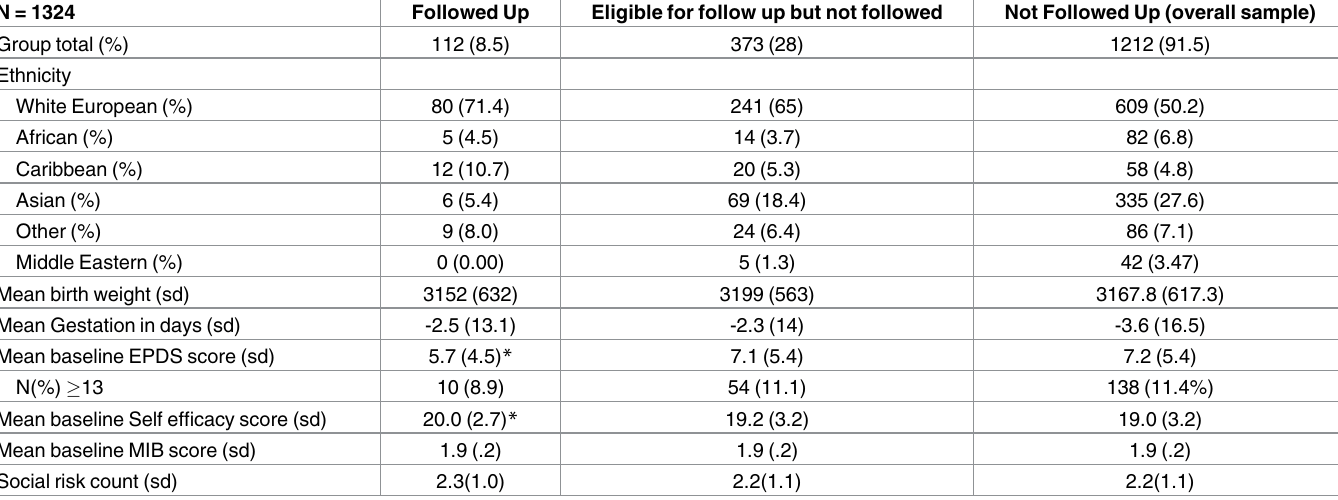
Table 1. Baseline data for ELSIPS follow up sample compared to a) all participants who were eligible to be followed but who were not followed and b) all participants who were not